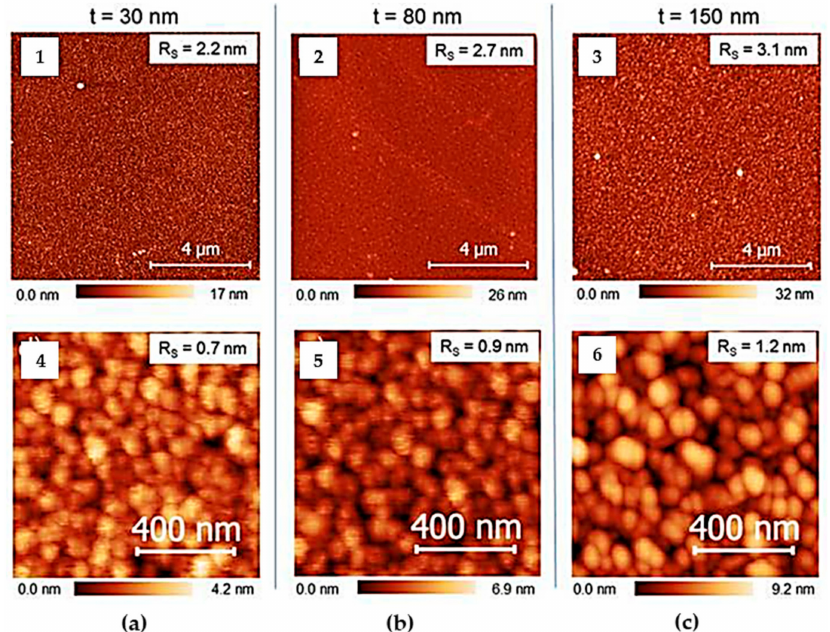
Figure 10. AFM images (10 µ m × 10 µ m) of Ag coatings deposited on Si at three di ff erent thickness values: ( a ) t = 48 ± 8, ( b ) 78 ± 12, and ( c ) 159 ± 19 nm. RMS roughness ( R s ) values are indicated in the label for each image. Reprinted with permission from [93]. © 2019 Elsevier.